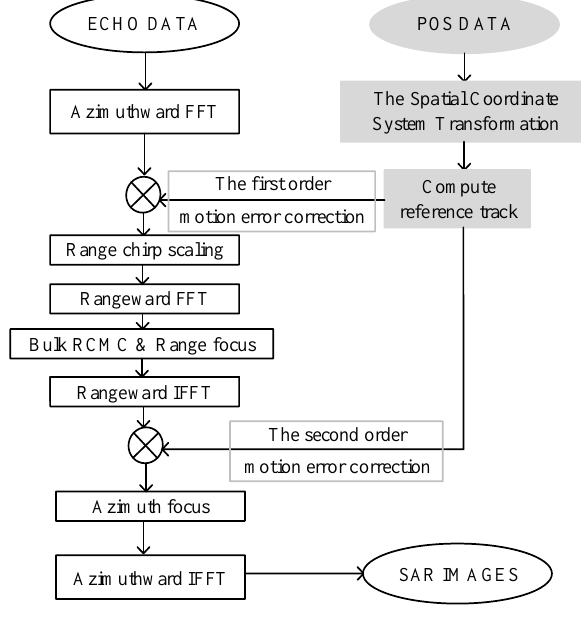
Figure 2. ECS algorithm flowchart